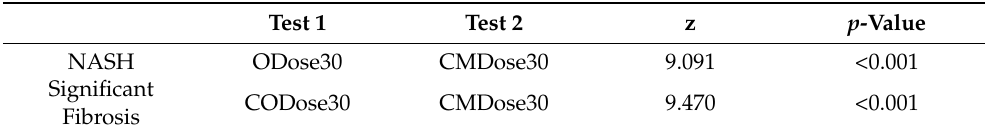
Table 5. Delong test for the best